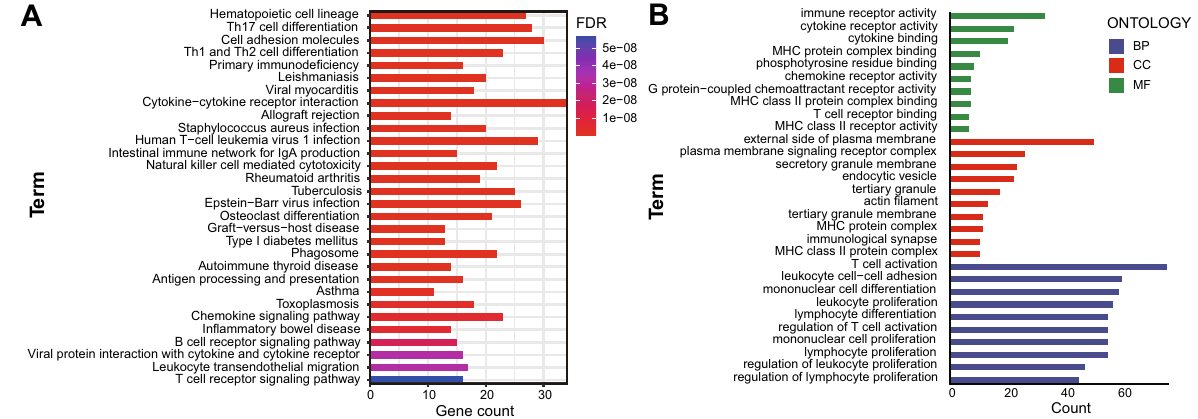
Figure 6. KEGG and GO analysis of differentially expressed genes co-existing in the training cohort and validation cohort. ( A ) Representative results of KEGG pathway analysis of differentially expressed genes. ( B ) Representative results of GO enrichment analysis of differentially expressed